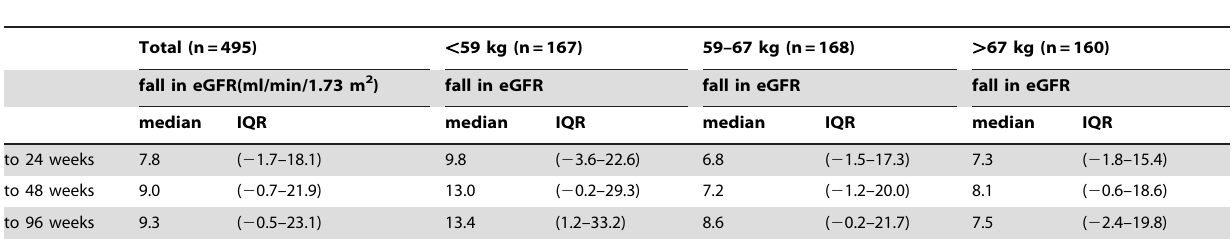
Table 5. Median and interquartile range of the actual fall in eGFR from the baseline to 24, 48, and 96 weeks, according to body weight.